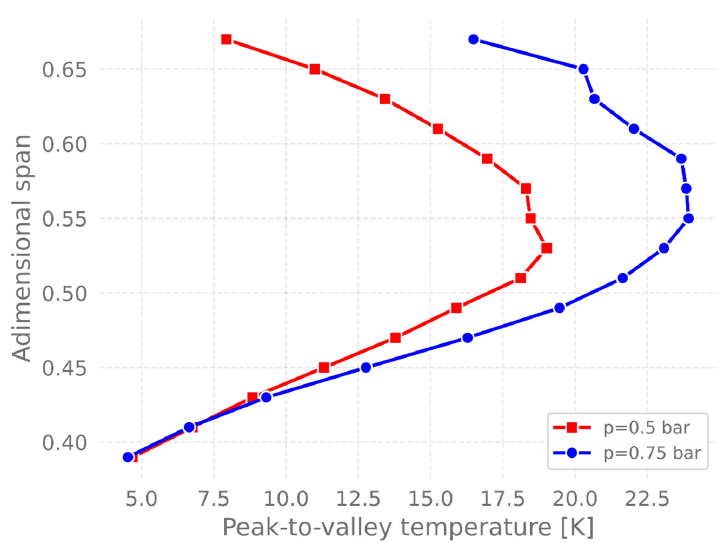
Figure 14. Effect of the feeding pressure increase on the circumferential average peak-to-valley temperature.